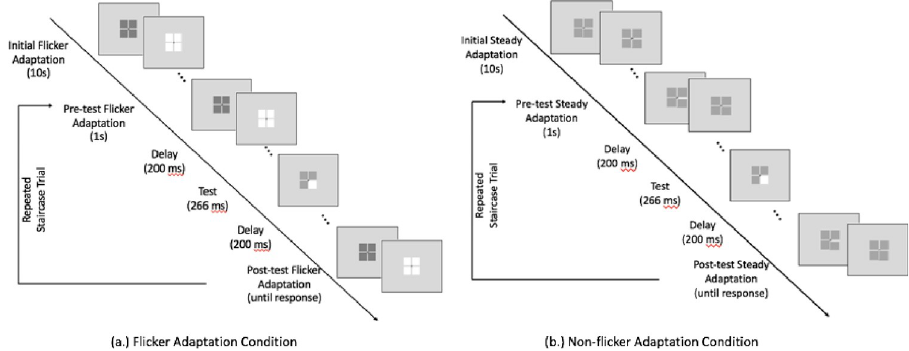
Fig 1. Schematic diagrams of the testing conditions in the steady- and pulsed-pedestal paradigms: (a) the flicker adapting condition and (b) the no-flicker condition.